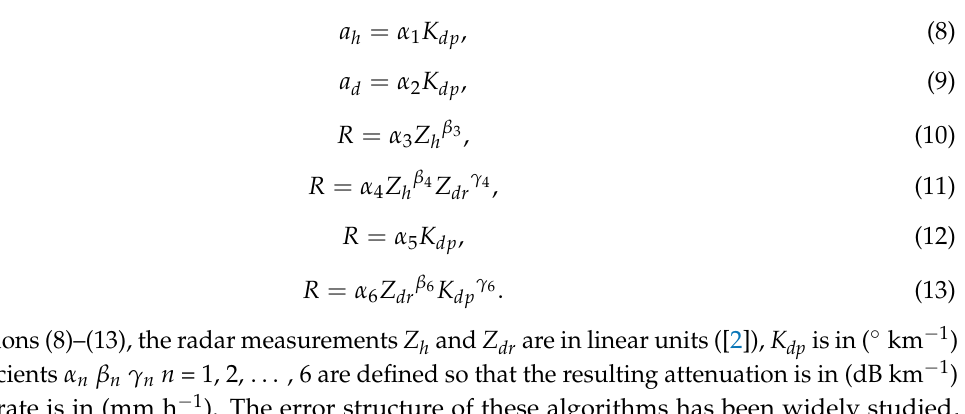
Figure 5. Ratio between backscattering cross section ( a ) and differences between forward scattering amplitudes ( b ) at horizontal and vertical polarization as function of equivalent drop diameter for S-band (green line), C-band (blue line) and X-band (red line).